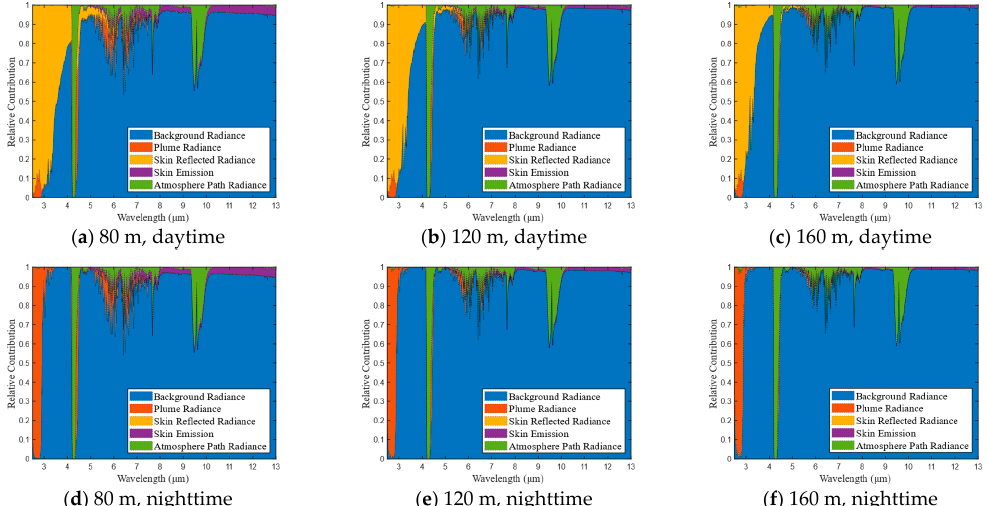
Figure 8. Relative contributions for the TOA radiance at 2.5–13 μ m. ( a – c ) are the contribution plots of three spatial resolutions in the daytime; ( d – f ) are the contributions plots in the nighttime; the blue, red, yellow, purple, and green areas represent the relative contribution of the background radiance, plume radiance, skin reflected radiance, skin emission radiance, and atmosphere path radiance respectively.